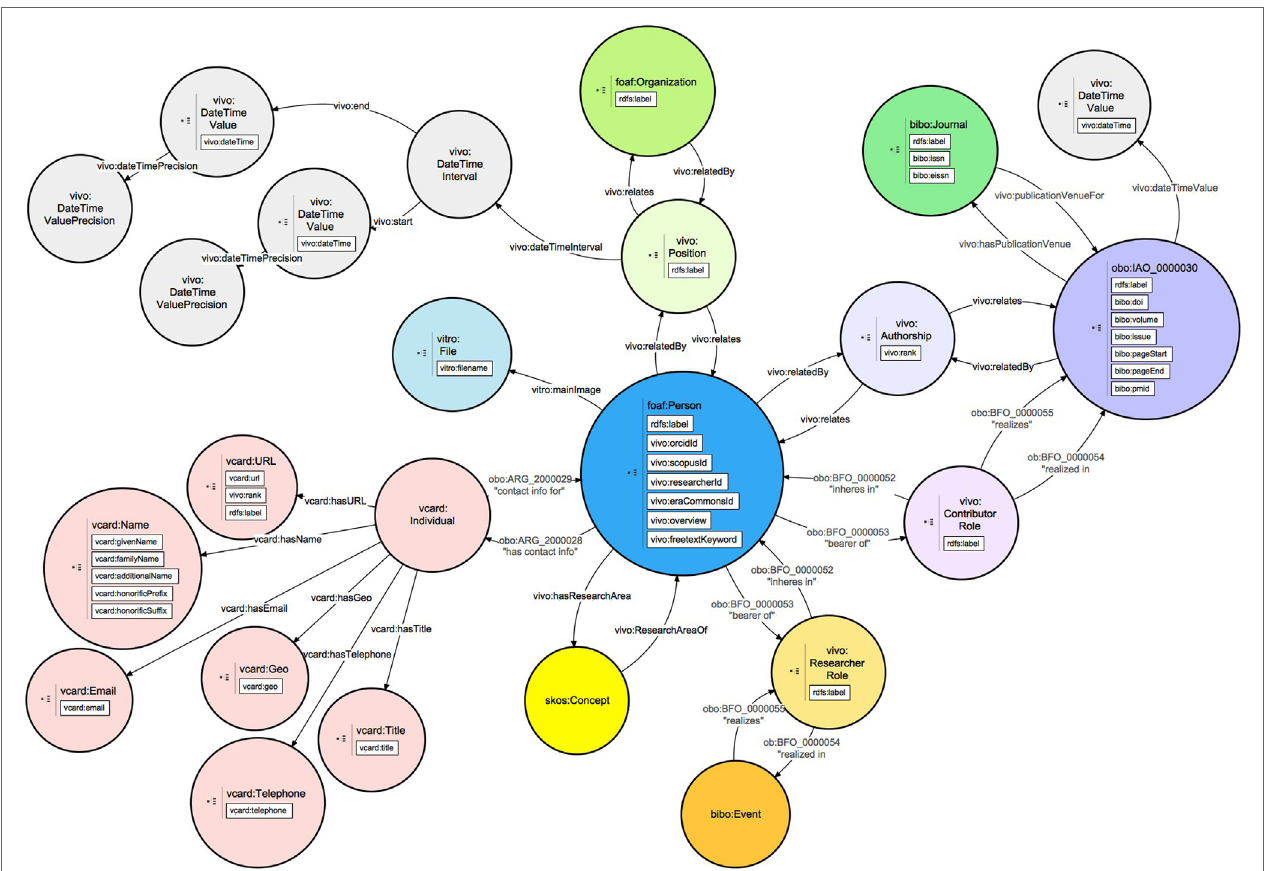
FIguRe 1 | OpenVIVO Person Model showing relationships to contact information, profile photograph, positions, academic works, events, and research areas.